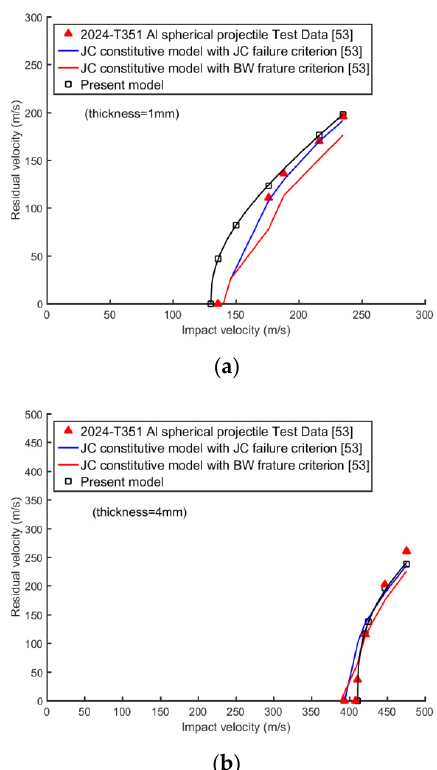
Figure 25. Comparisons of the numerically predicted residual velocities with the test results for the perforation of 2024-T351 aluminum alloy plates struck normally by the 7.5-mm-diameter spherical projectile. ( a ) 1-mm plate; ( b ) 4-mm plate. projectile. ( a ) 1-mm plate; ( b ) 4-mm